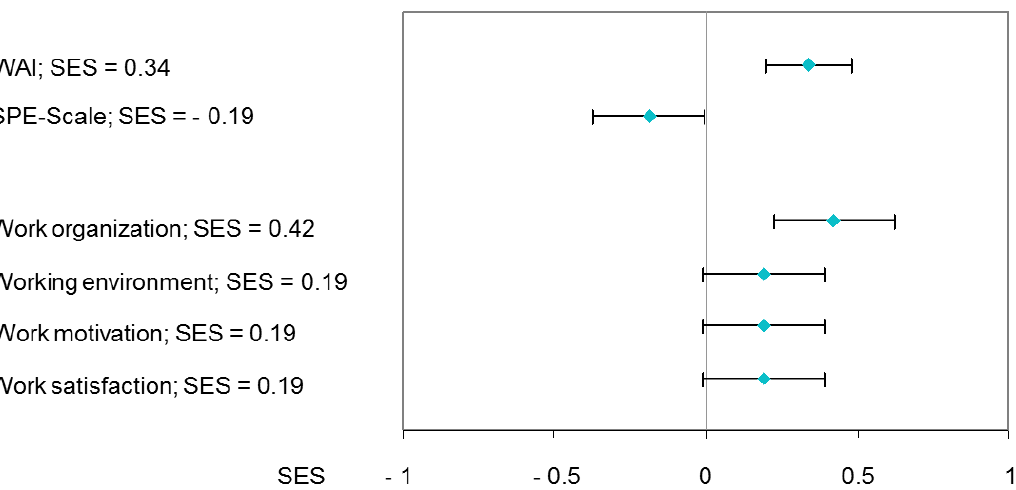
Figure 3. WAI ( n = 94), SPE-scale ( n = 97) and working conditions ( n = 97); Standardized effect sizes (SES).